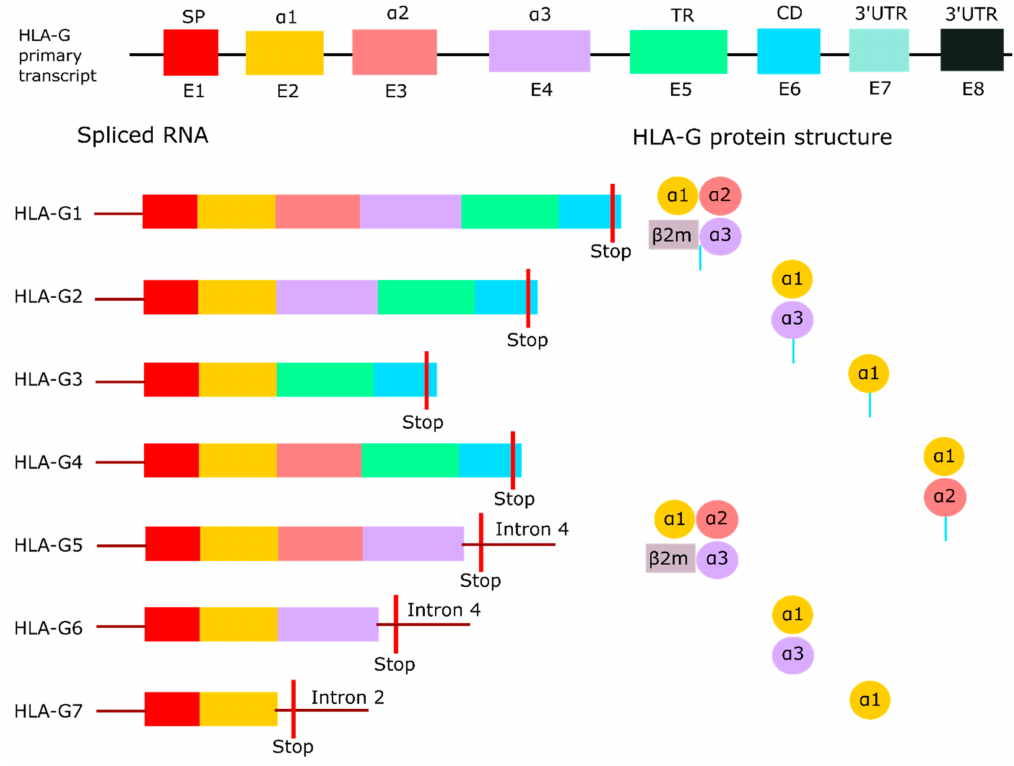
Figure 1. HLA-G isoforms. Overview of the full-length HLA-G primary transcript with its seven isoforms produced by alternative splicing. HLA-G1 to -G4 are membrane-bound due to the containment of the transmembrane region, while HLA-G5 to -G7 are soluble as a result of an early stop codon in intron 2 or intron 4. HLA-G1 and -G5 are the only isoforms that can bind the light chain β 2M. Adapted from Krijgsman et al. [33]. Abbreviations: β 2-microglobulin ( β 2M), cytoplasmic domain (CD), exon (E), human leukocyte antigen G (HLA-G), signal peptide (SP), three prime untranslated region (3 (cid:48) UTR), transmembrane region